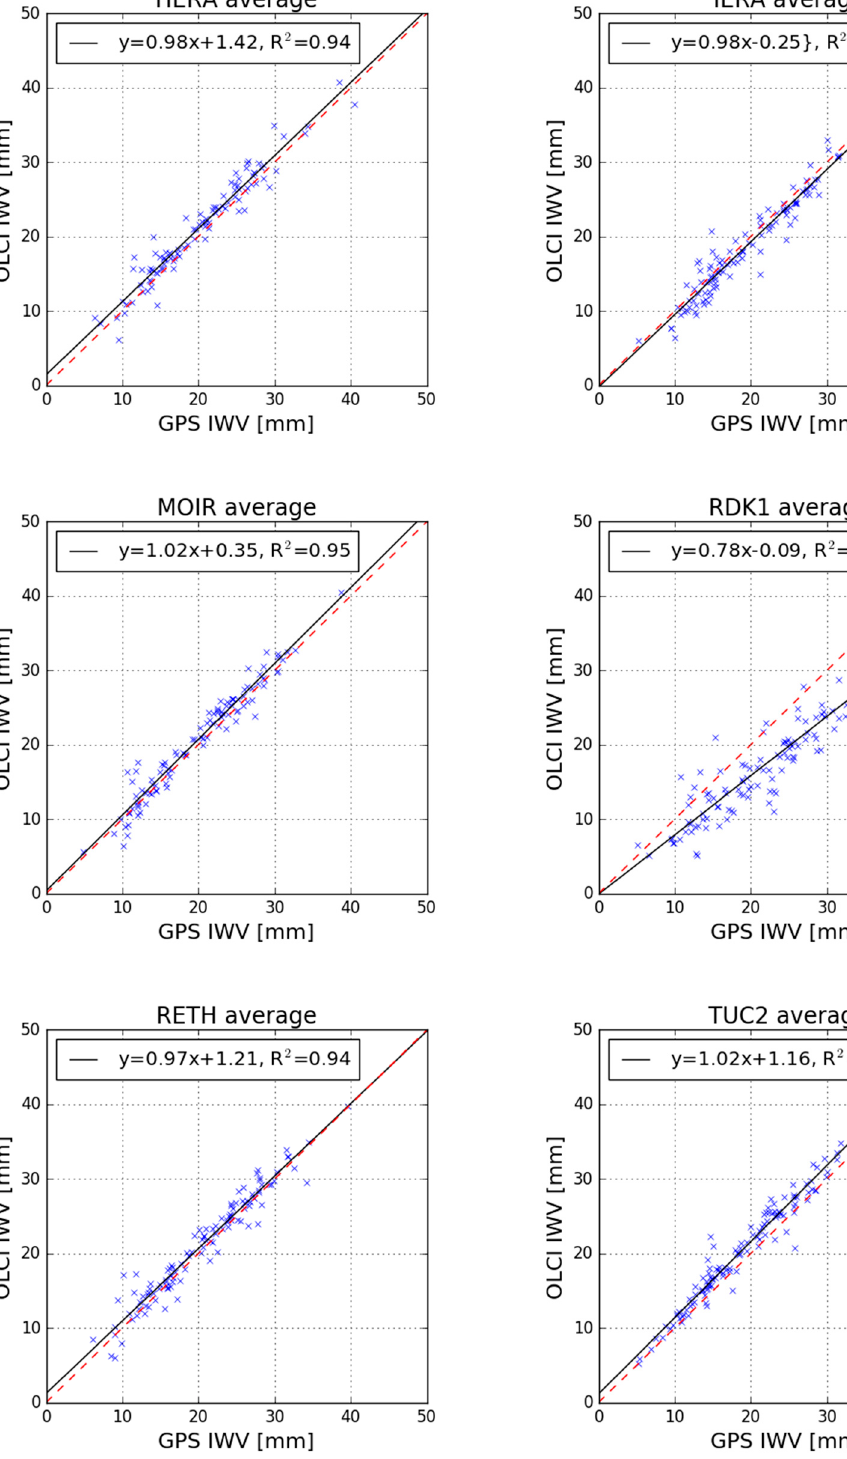
Figure 10. Scatterplots of simultaneous IWV measurements obtained by the Sentinel-3B OLCI instrument as derived by the “area of influence” approach and the GNSS station at the respective station location.